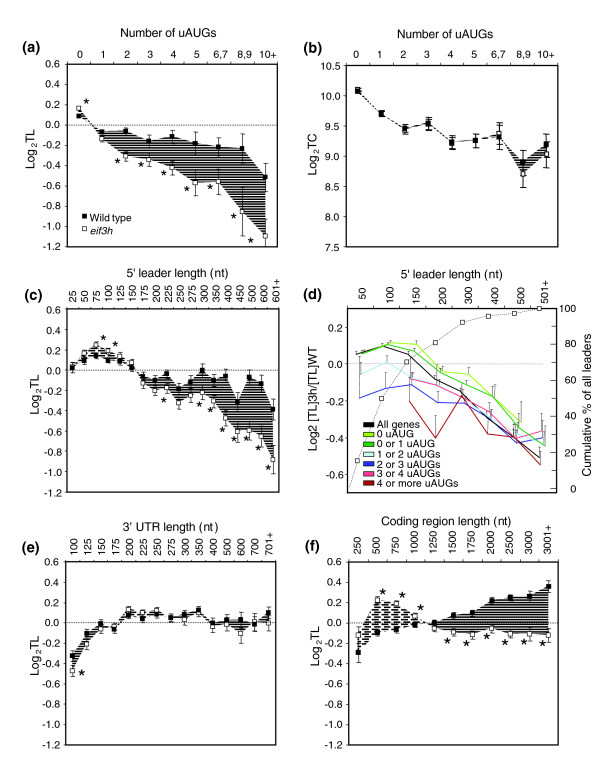
Identification of structural parameters that predict mRNA polysome loading in wild type and eif3h mutants. The average translation state of mRNAs was plotted separately for wild-type and eif3h mutant plants after subdividing the transcriptome (5,101 genes with polysome loading data and full-length cDNA support) according to the following parameters: (a) number of uAUGs in the 5' leader; (b) the eif3h mutation did not cause a global reduction in mRNA transcript levels for uORF-containing mRNAs; (c) length of the 5' leader in nucleotides (nt); (d) similar to (c), but leaders were classified into subgroups according to the number of uORFs. For clarity, we plotted only the difference in translation state between eif3h and wild type (colored lines). The stippled line denotes the percentage of leaders in each length class (cumulative). (e) Length of the 3' untranslated region. (f) Length of the protein-coding region of the main ORF. Standard errors are shown. The asterisk indicates a significant difference between the translation state in wild type and eif3h mutant (p < 0.05) according to a t-test (unpaired, two-tail).